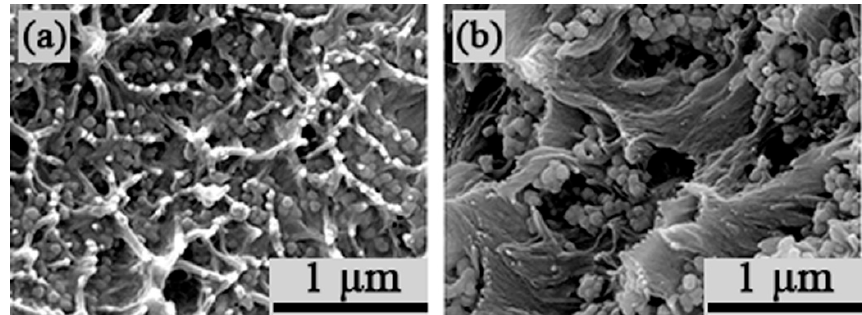
Figure 7. ( a ) SEM image of BT@ZnPc-2/PEN film; ( b ) SEM image of BT@ZnPc-2/PEN film after isothermal annealing at 280 °C for 5 hours. isothermal annealing at 280 ◦ C for 5